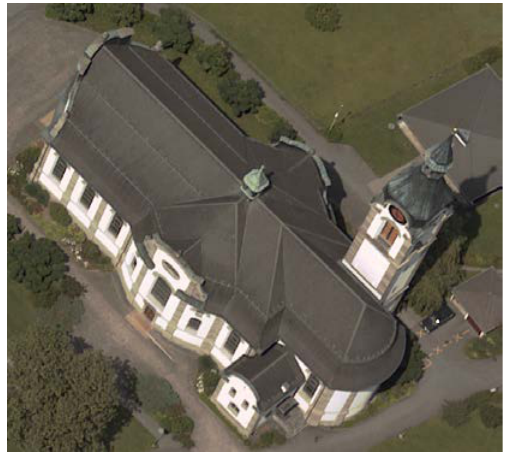
Figure 3. Oblique image of the church (forward view)